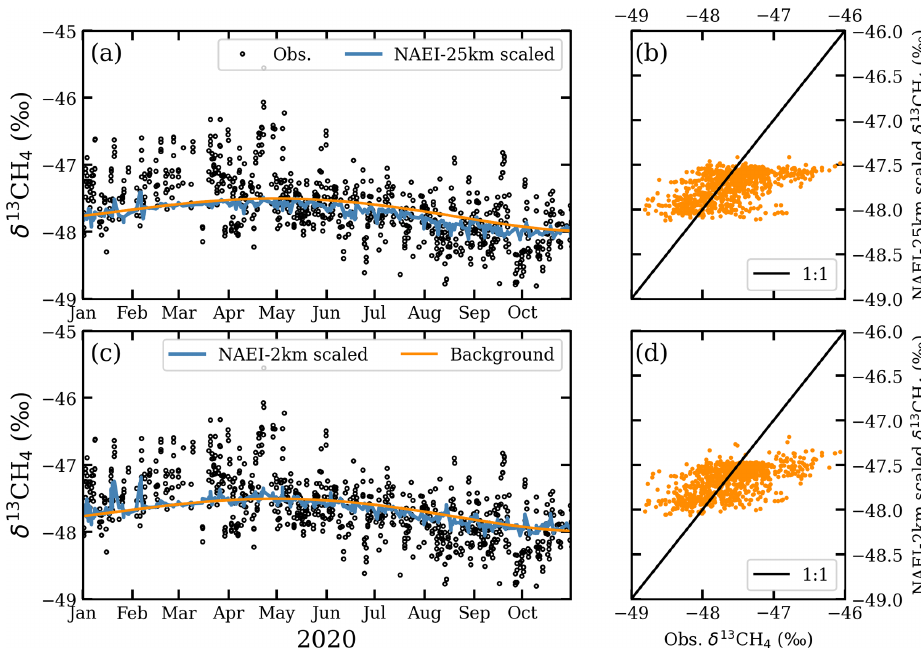
Figure 13. Time series comparison of simulated (a) NAEI-25km and (c) NAEI-2km δ 13 CH 4 recalculated by scaling the simulated natural gas mole fractions, along with observations for afternoon hours. Simulation–observation comparisons of δ 13 CH 4 using linear regressions for (b) NAEI-25km and (d) NAEI-2km for 2020 afternoon hours. Table 6. Mean simulated source apportionment for excess CH 4 at Imperial College London and in the CH 4 emissions for London. Source Sector